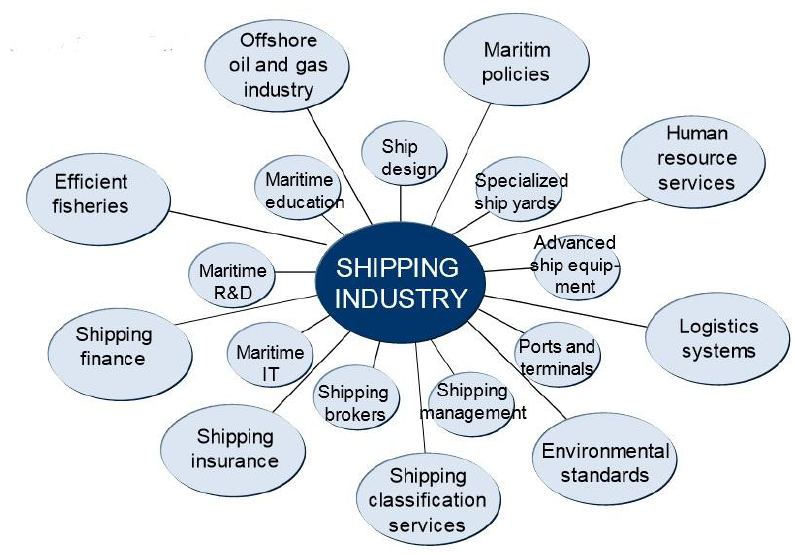
Figure 3. Shipping industry supporting structure. Source: Indonesian Main Sea-Corridor [13].